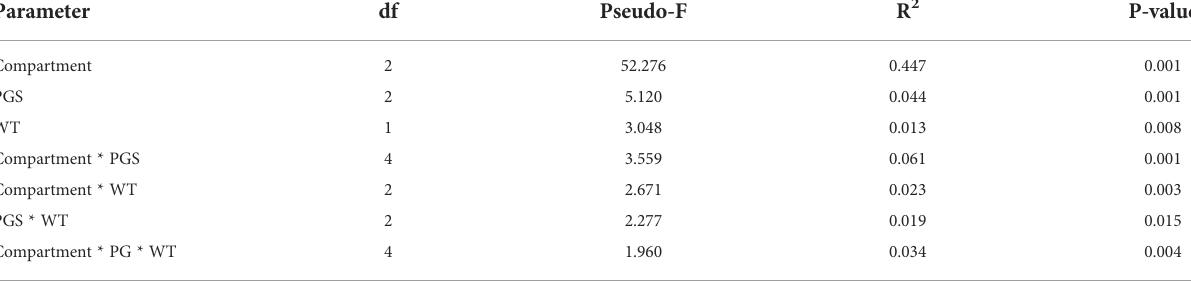
TABLE 1 The effect of the soil-plant compartment, plant growth stage (PGS) and watering treatment (WT) on the wheat mycobiota structure. Parameter df